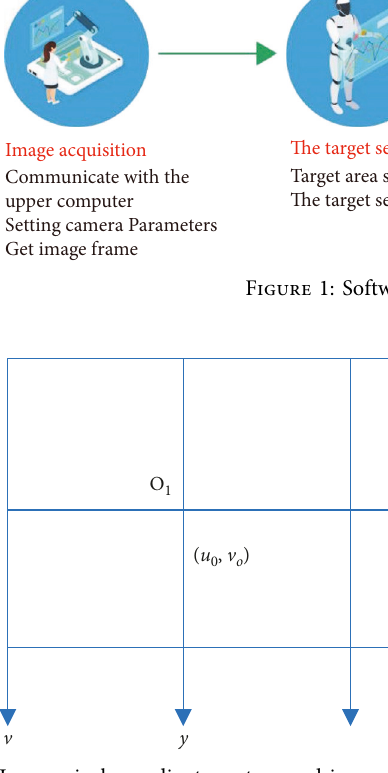
Figure 2: Image pixel coordinate system and image physical co- ordinate (3) Image pixel coordinate system is expressed as O o uv . The origin O represents the pixel point in the upper 0 left corner of the digital image. The basis of the u -axis and v -axis is pixels, where the u -axis represents pixel lines and the v -axis represents pixel lines.